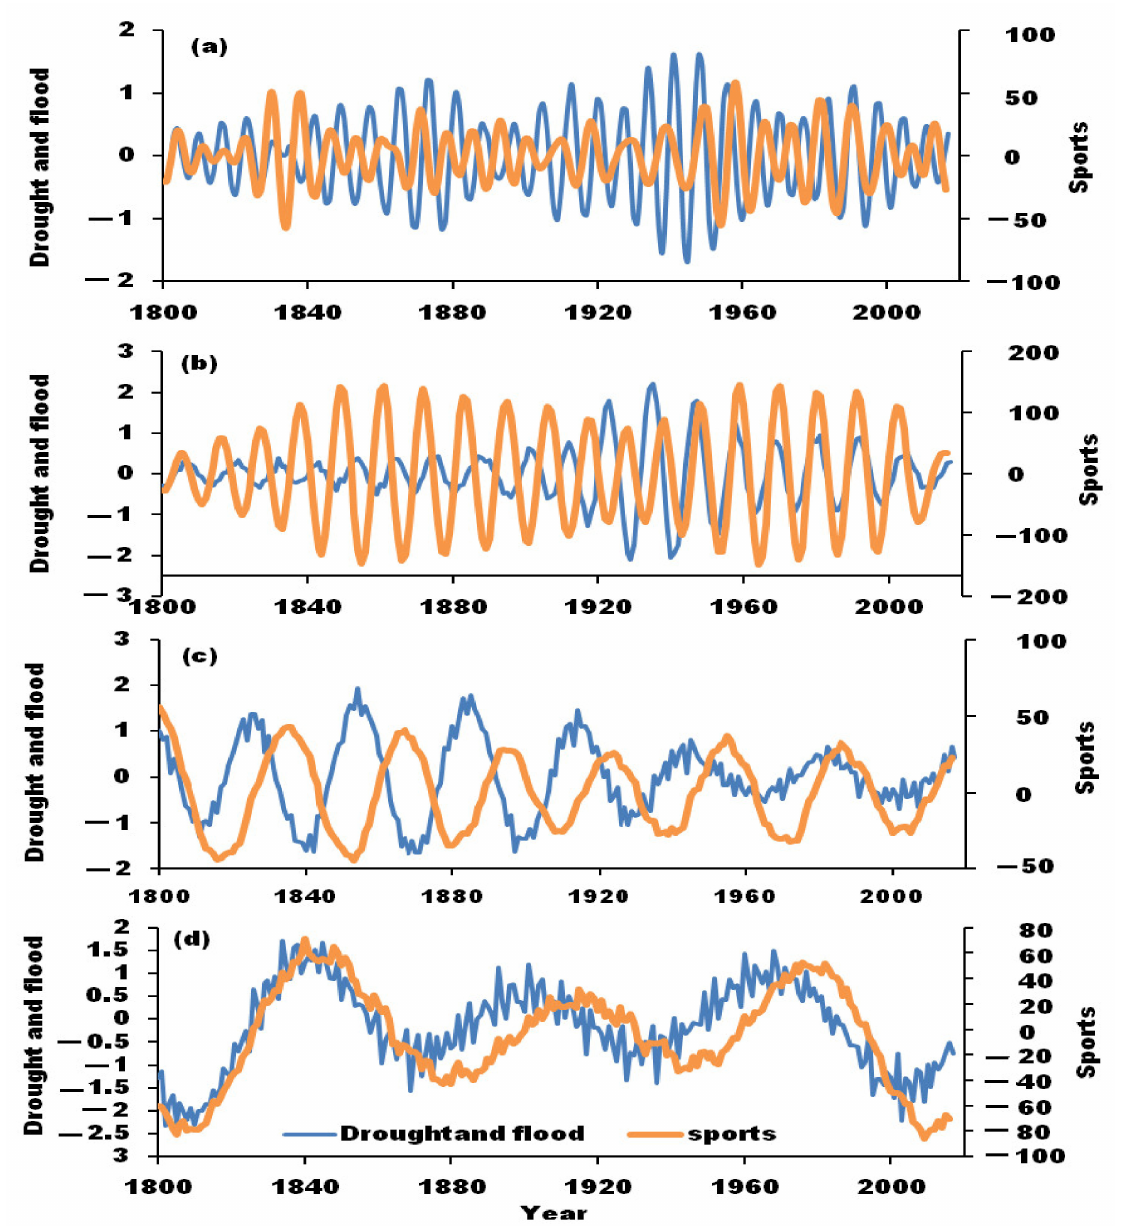
Figure 11. Correlation of droughts/floods and sunspot activities component from 1800 to 2017. ( a ): 11-year cycle component; ( b ): 18-year cycle component; ( c ): 45-year periodic component; ( d ): 102-year periodic